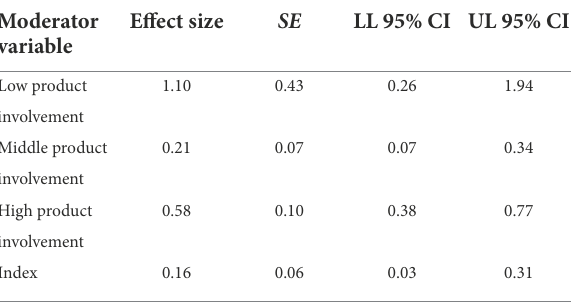
TABLE 4 Results for the effect of CPEC on consistency brand attitude across levels of product